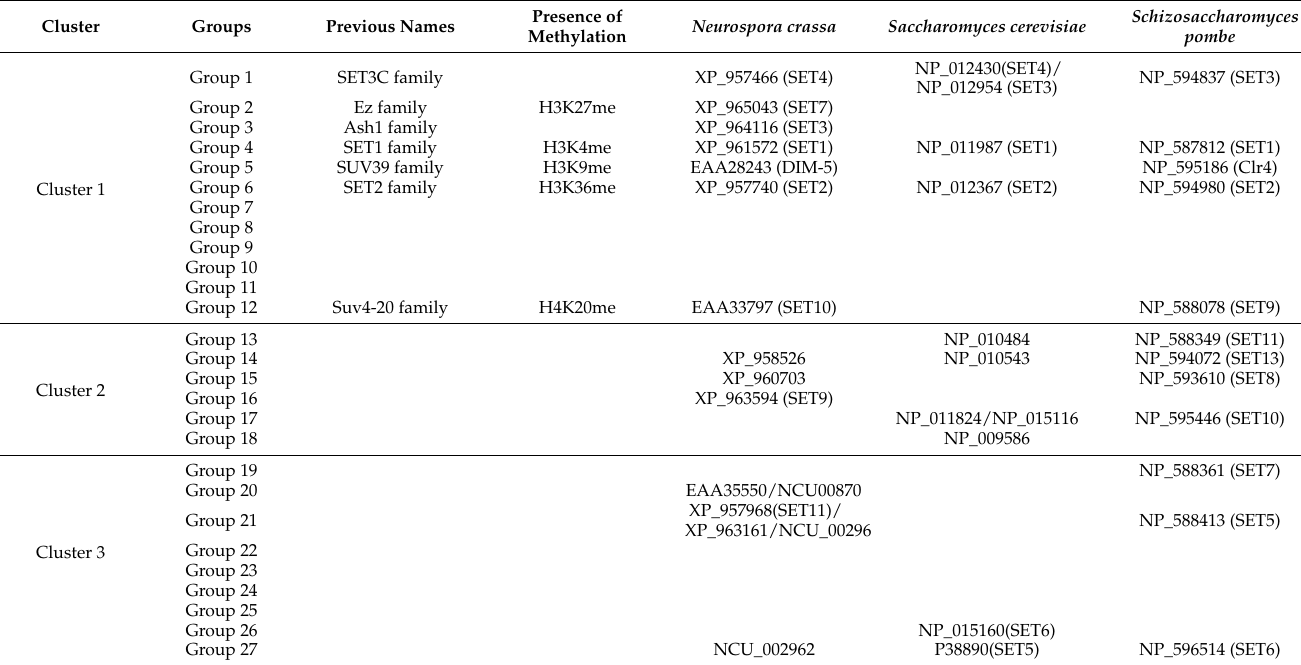
Table 1. Distribution of the SET Domain Proteins in N. crassa , S. cerevisiae and S. pombe